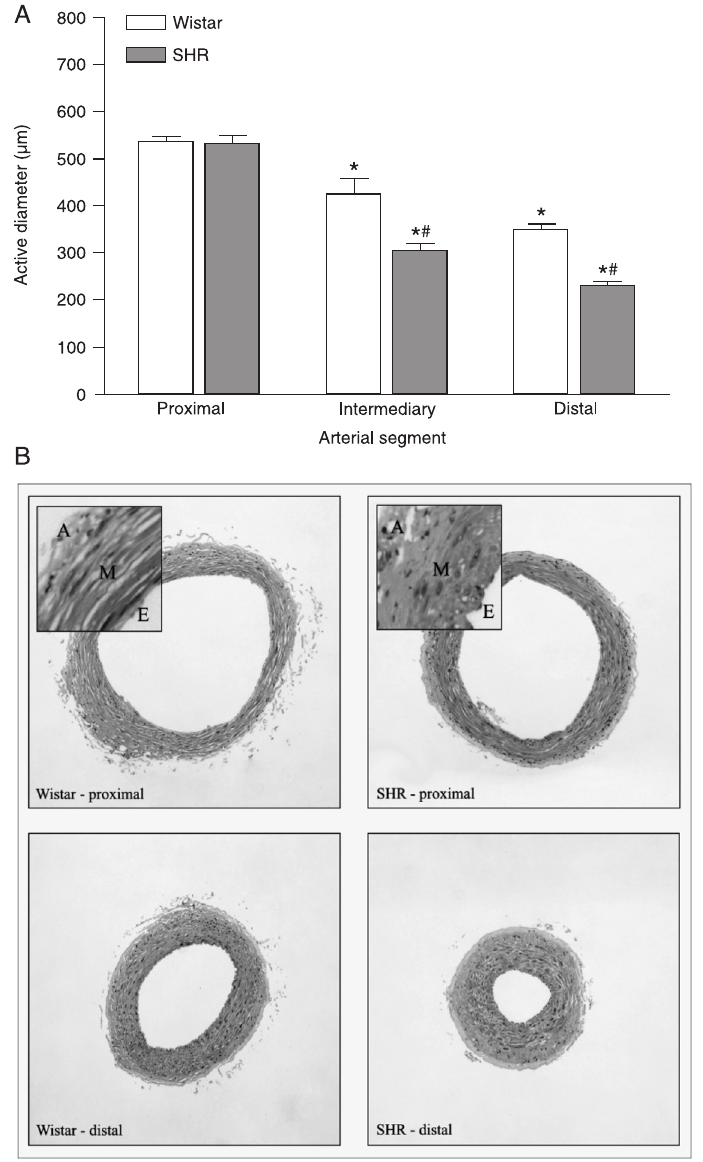
Figure 3. A , Active internal diameters of tail arteries from Wistar rats (N = 4 animals) and spontaneously hypertensive rats (SHR, N = 5 animals) fixed at a volumetric flow rate of 2.5 mL/min. *P < 0.05 vs proximal portion; # P < 0.05 vs Wistar rats (two-way ANOVA followed by the Bonferroni post hoc test). B , Photomicrograph of transverse sections of proximal and distal tail artery from Wistar rats and SHR. Magnification: 10X. Inset panels in the proximal tail artery photomicrographs of Wistar and SHR are amplified images showing the en - dothelial (E), medium (M) and adventitial (A) layers of the